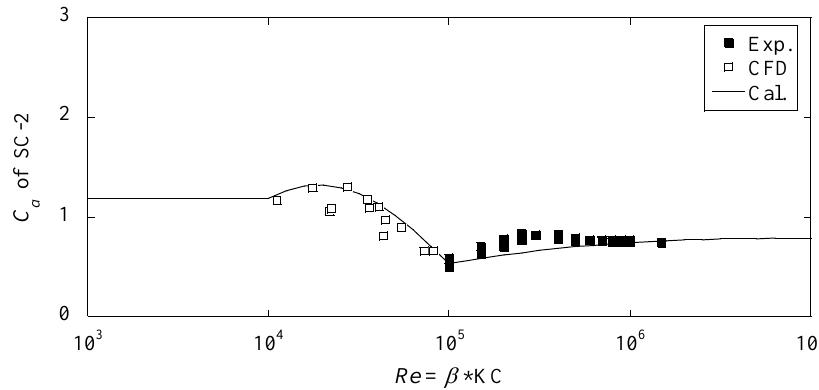
Figure 2. Variation of C a for SC-2 with Reynolds ( Re ) number in the oscillatory flow.